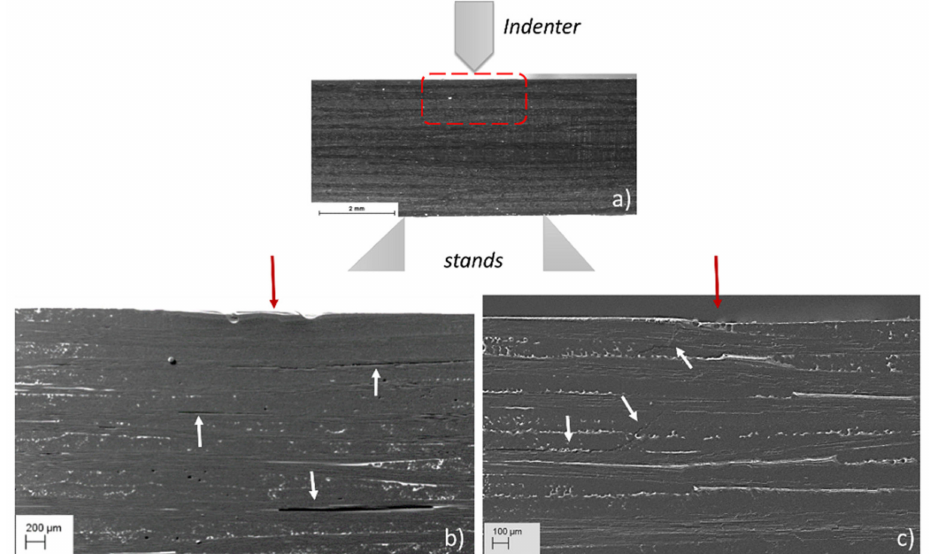
Figure 4. ( a ) Macrograph of the specimen cross-section under investigation and SEM micrographs showing the damage evolution in the compression side of ( b ) SBS_100 and ( c ) SBS_120 specimen after the test. (The red arrows indicate the loading point while the white arrows indicate the extensive damage formed in the specimen cross